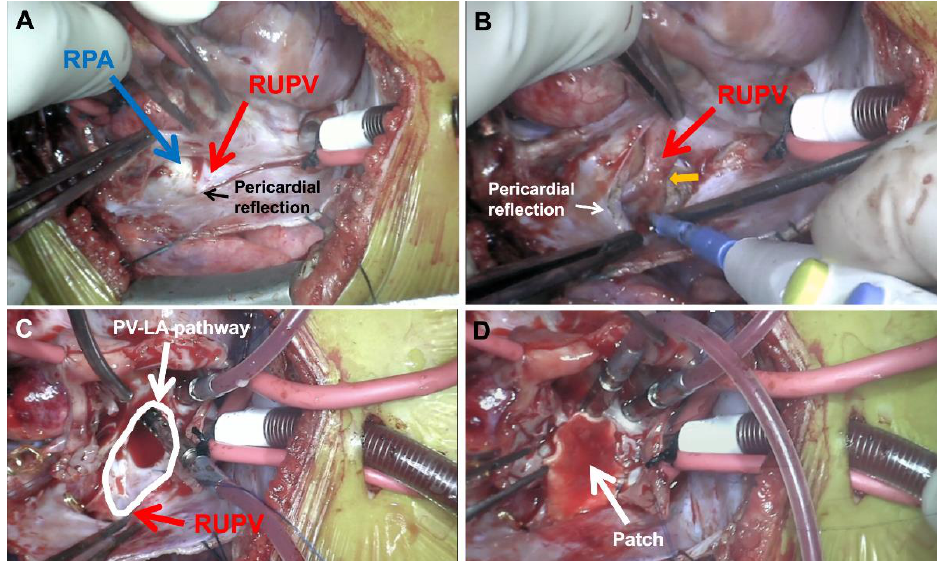
Figure 4. Right pulmonary vein repair. ( A ) Right-sided pulmonary veins crossing pericardial reflec- tion before entering left atrium more medially; ( B ) Complete mobilization of pericardial reflection and right pulmonary veins with stenotic region denoted (yellow arrow); ( C ) Right pulmonary veins widely opened up and diseased tissue resected creating patulous pulmonary vein-left atrial pathway (white outline); ( D ) Patch augmentation moves pulmonary vein-left atrial connection out laterally to shorten/straighten pulmonary vein course. (RUPV = right upper pulmonary vein; RPA = right pulmonary artery; PV-LA = pulmonary vein-left